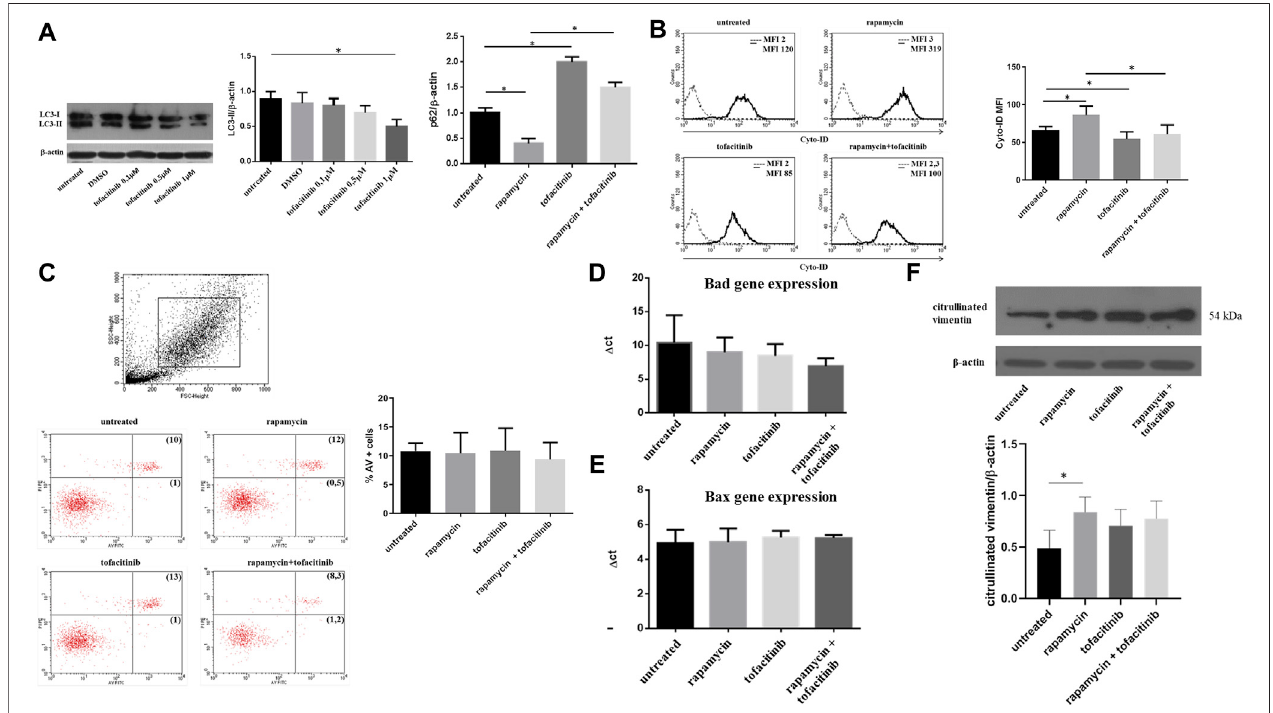
FIGURE1| Autophagy,apoptosis andcitrullinated proteinslevelsafter invitro treatment withtofacitinibinFLSisolatedfromRApatients. (A) .Westernblotanalysis of LC3-II and p62 levels of RA-FLS treated with tofacitinib (1uM) alone and in combination with rapamycin (200 nM). Blots shown are representative of fi ve independent experiments performed using FLS samples from fi ve different RA patients. Densitometry analysis of LC3-II and p62 levels relative to β -actin is also reported. Values are expressed as means ± sd. * p < 0.05 (B) . Analysis of autophagosomes number in FLS treated with tofacitinib as previously described ( n = 5). Values of mean fl uorescence intensity (MFI) obtained by fl ow cytometry are reported. * p < 0.05 (C) . Statistical analysis of apoptosis of FLS isolated from patients with RA ( n = 5) after in vitro treatment with tofacitinib. Results are expressed as AV-positive cells. Dot plots (PI on y axis vs. AV on x axis) representative of fi ve independent experiments are alsoshown. (D,E) .BadandBaxexpressionsofFLStreatedwithrapamycin(200 nMfor4 h)andtofacitinib(1 uMfor20 h)analyzedbyQuantitativeReal-timePCR(qRT- PCR). Data are reported as differences between their Ct and the housekeeping gene GAPDH Ct ( Δ Ct). (F) . Western blot and densitometry analysis of